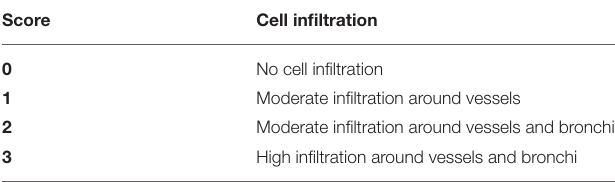
TABLE 1 | Lung inflammation histological